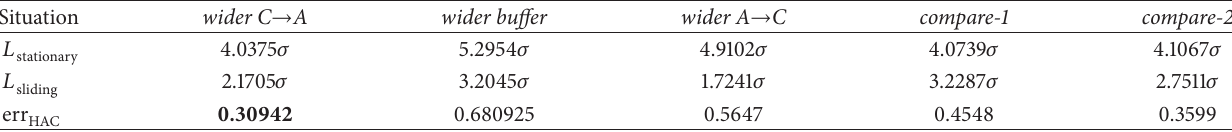
Table 7: Slip length prediction of five situations and unified relative errors with different widths of the functional regions.